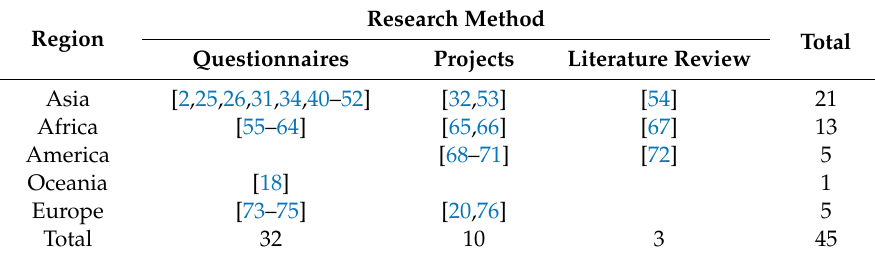
Table 2. Studies on cost overrun factors related to road projects ( n =